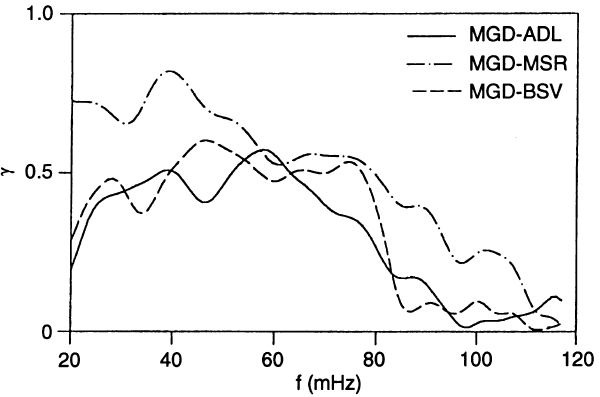
Fig. 8. Coherency coe(cid:129)cients c (cid:133) f (cid:134) for the event 2 for D component between stations with di(cid:128)erent L -values